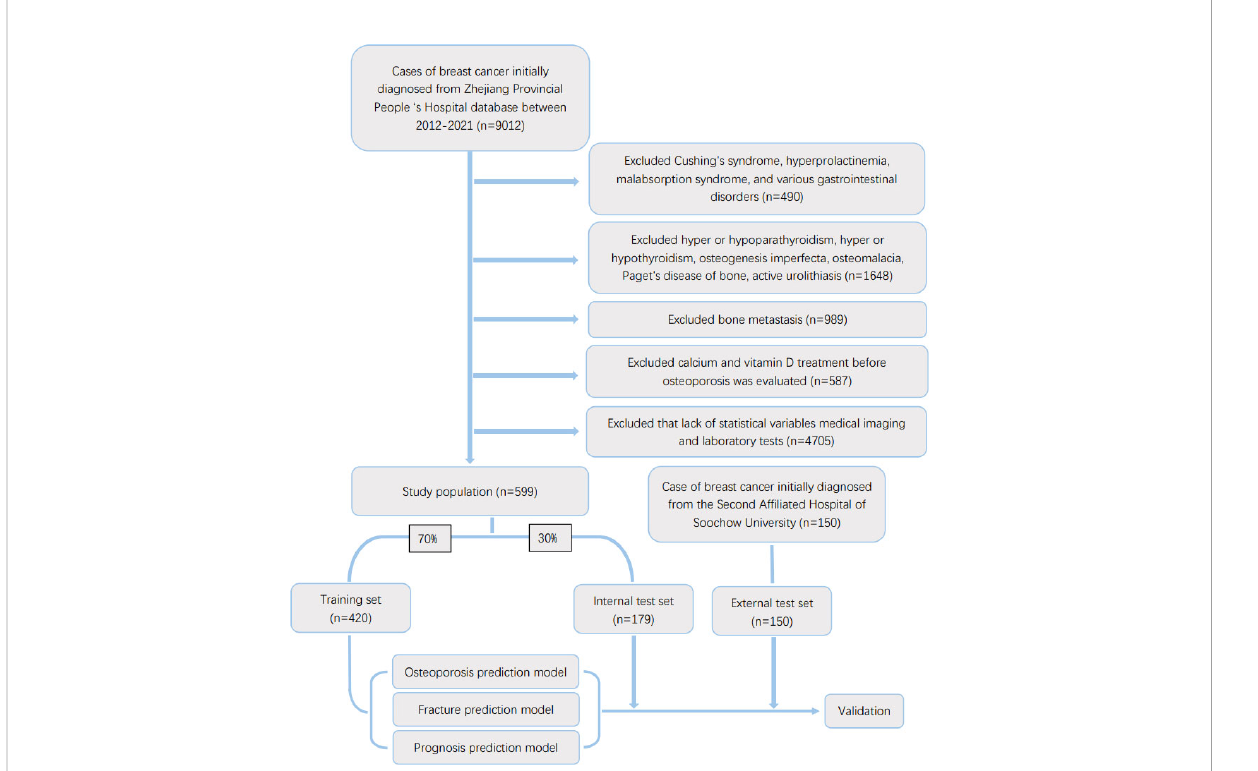
FIGURE 1 Flow diagram of the study population selected from Zhejiang Provincial People ’ s Hospital and the Second Af fi liated Hospital of Soochou University. According to the inclusion and exclusion criteria, a total of 599 patient were included in this study,and they were randomly cut into the training and internal test sets in a 7:3 ratio. Data from the Second Af fi liated Hospital of Soochou University as an external test